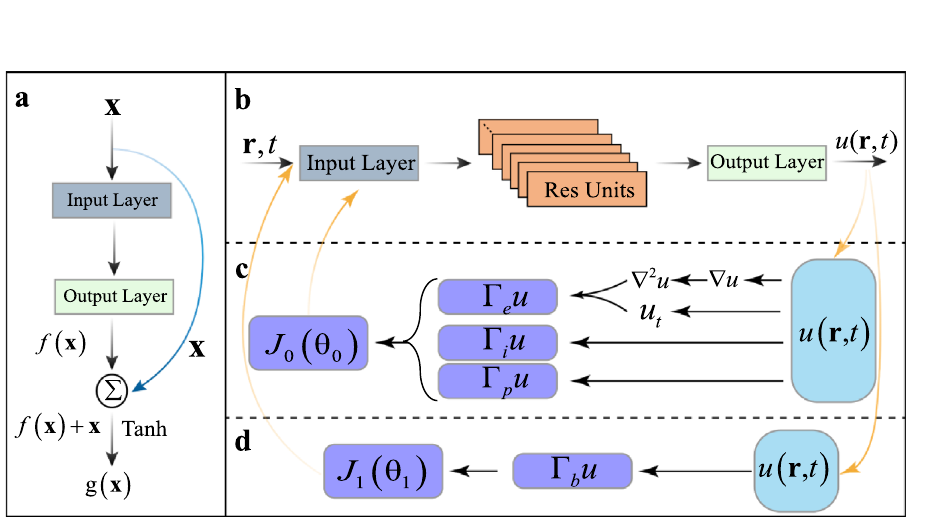
Figure 1. PINN with residual units. ( a ) The composition of residual unit; ( b ) PINN based on residual units; ( c ) The forward solution for the partial derivatives with physical constraints; ( d ) The backward solution for the partial derivatives with physical